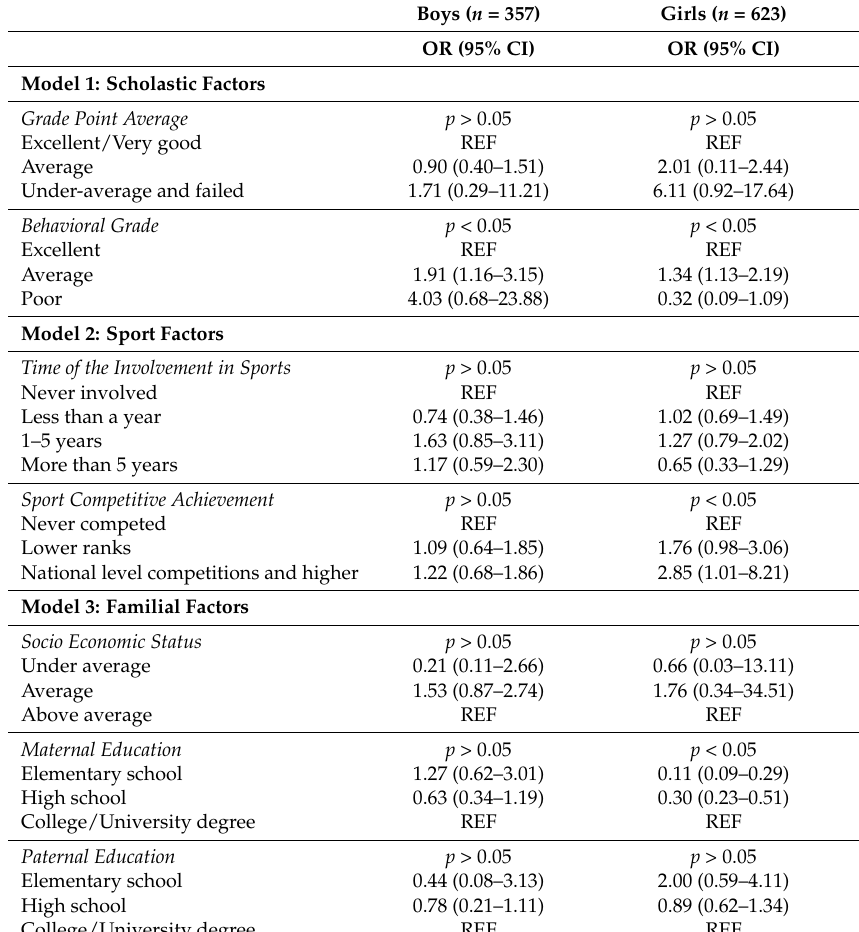
Table 2. Logistic regression models for harmful drinking in boys and